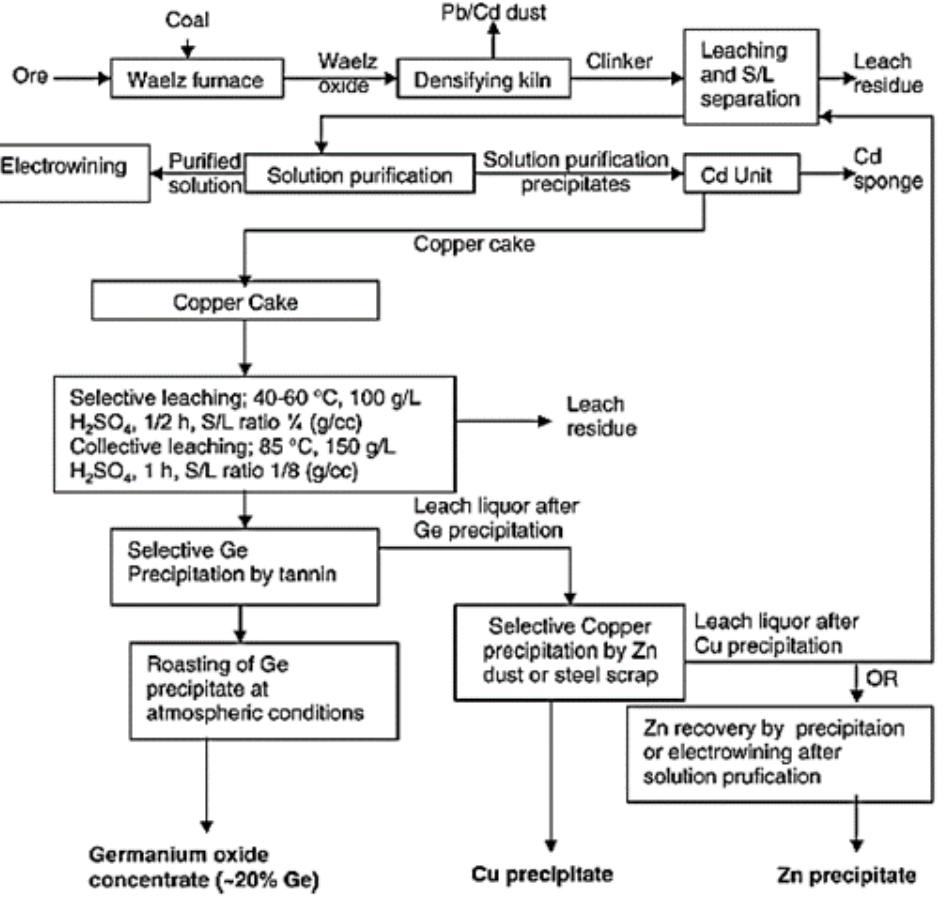
Figure 7. Flow sheet of the Cinkur plant in Turkey